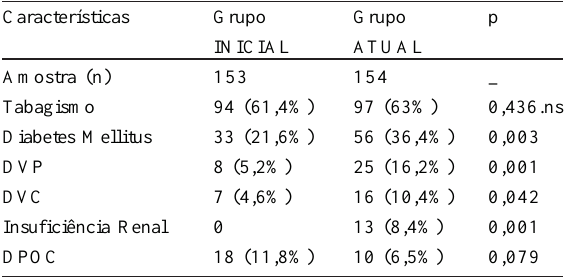
Tabela 3. Co-morbidades presentes nos